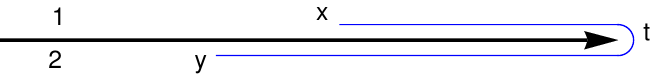
Figure 3 . Path for the gauge link in the Schwinger-Keldysh contour. The path in the full spacetime dimension is determined by a straight path joining x and y , which is extended to future infinity.